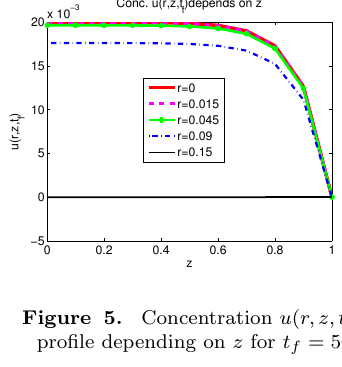
Figure 5. Concentration u ( r,z,t f ) profile depending on z for t f = 50